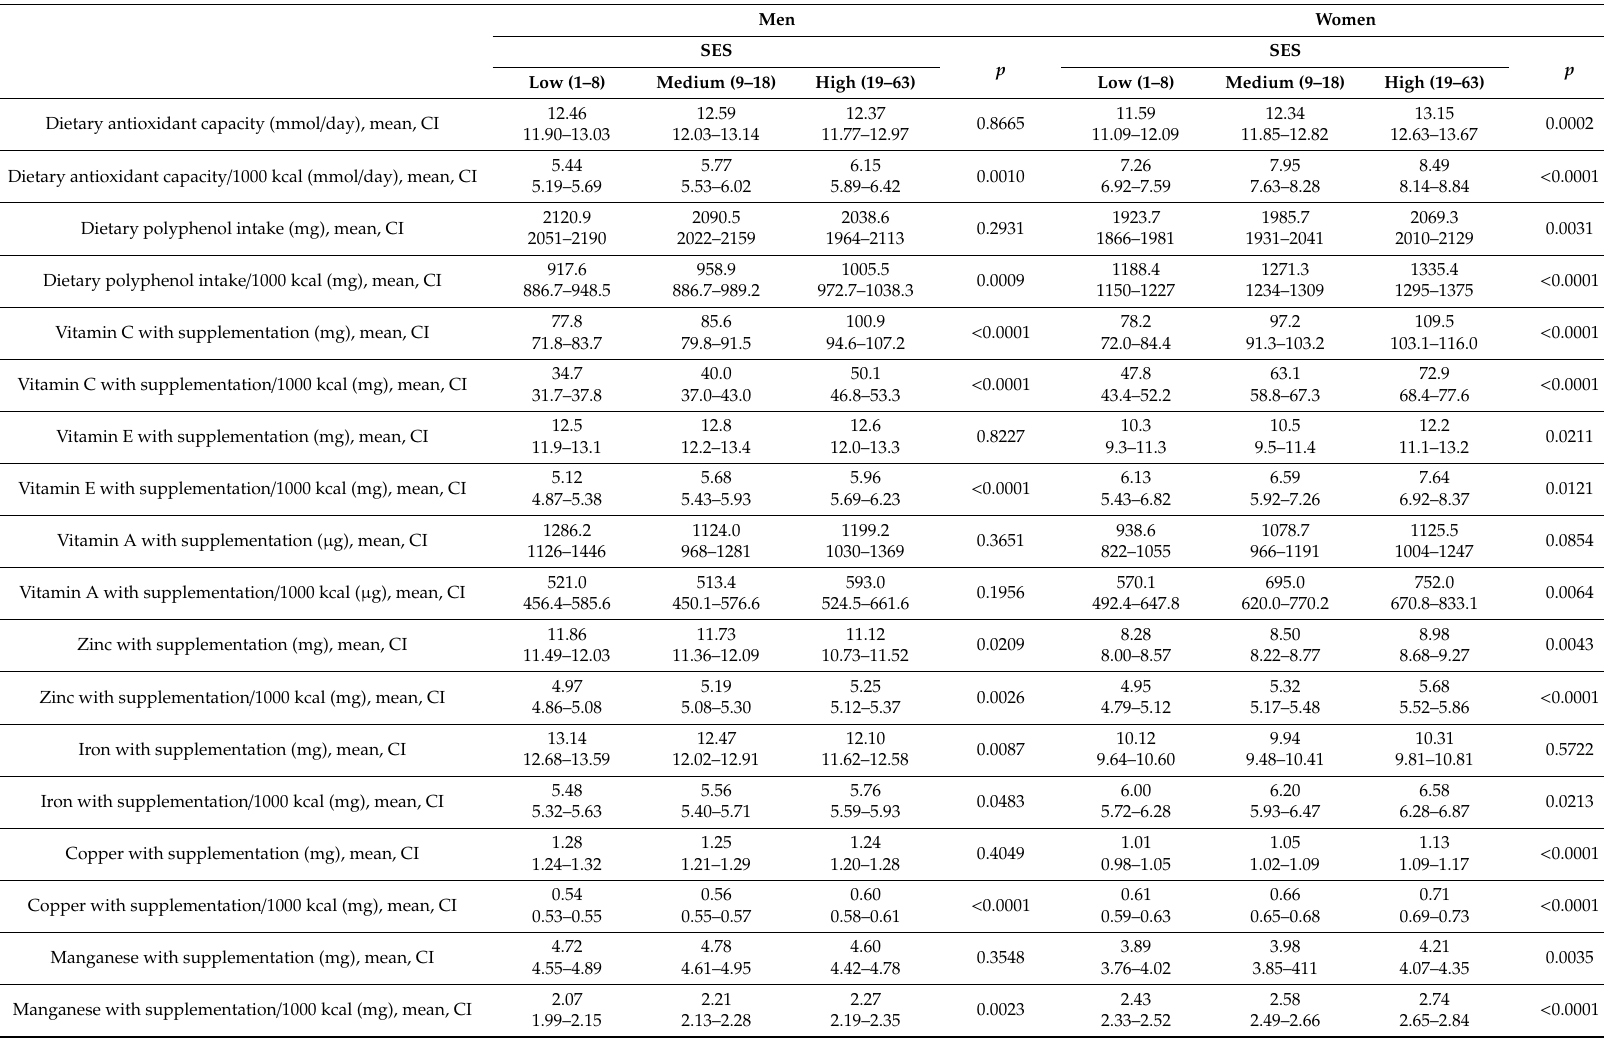
Table 4. Dietary antioxidants intake according to socioeconomic status (SES) score, adjusted for